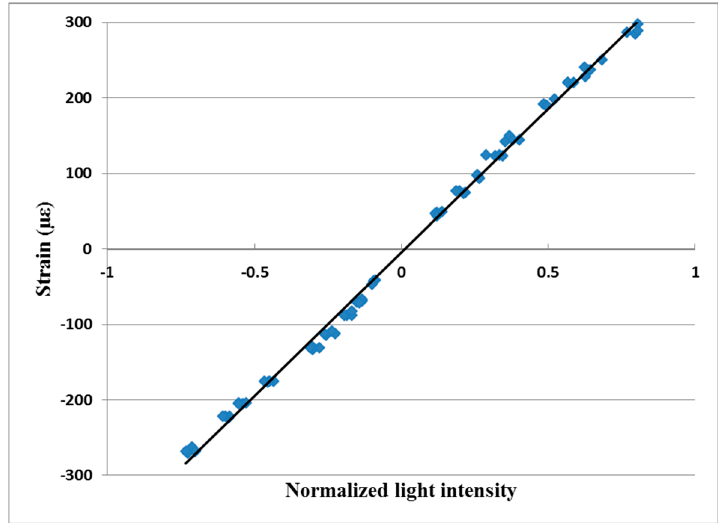
Figure 6. Relation between the strain and normalized light intensity.